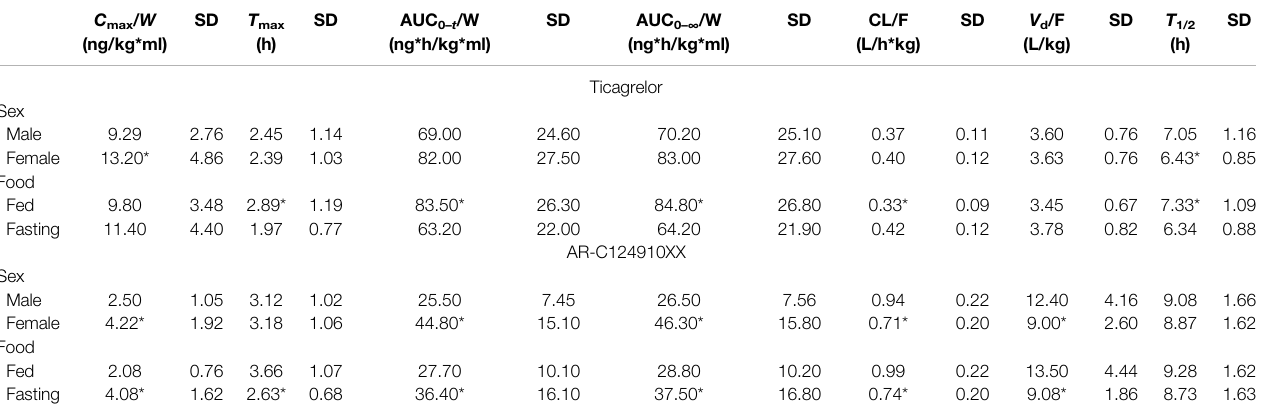
TABLE 2 | Main pharmacokinetic parameters of ticagrelor and AR-C124910XX based on sex and food C W max /